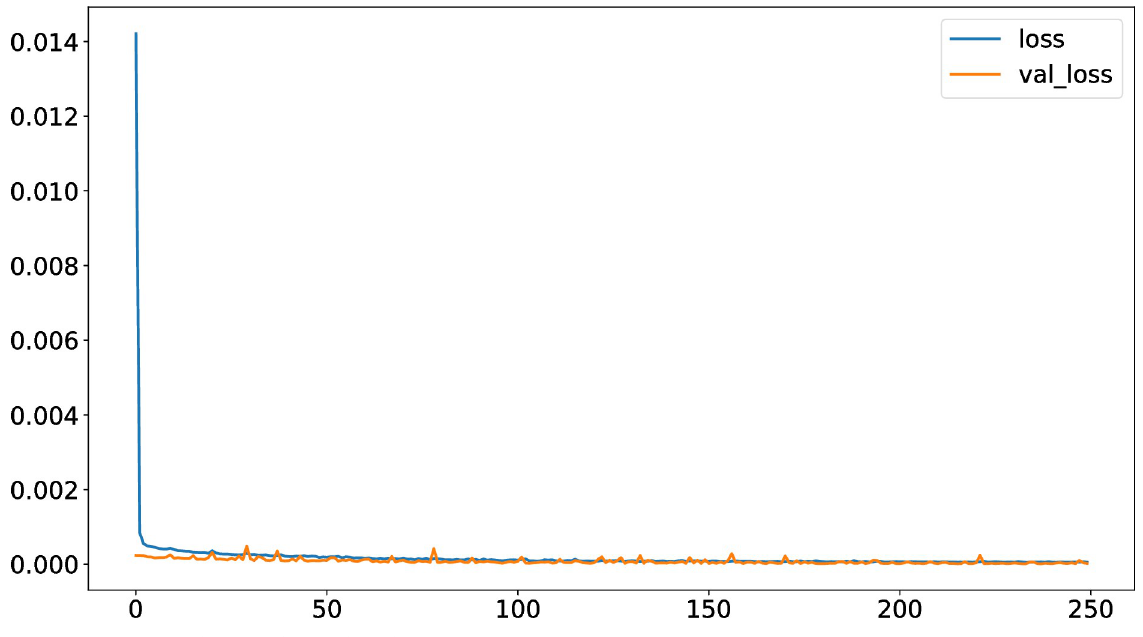
Fig 7. Error variation diagram of AGA